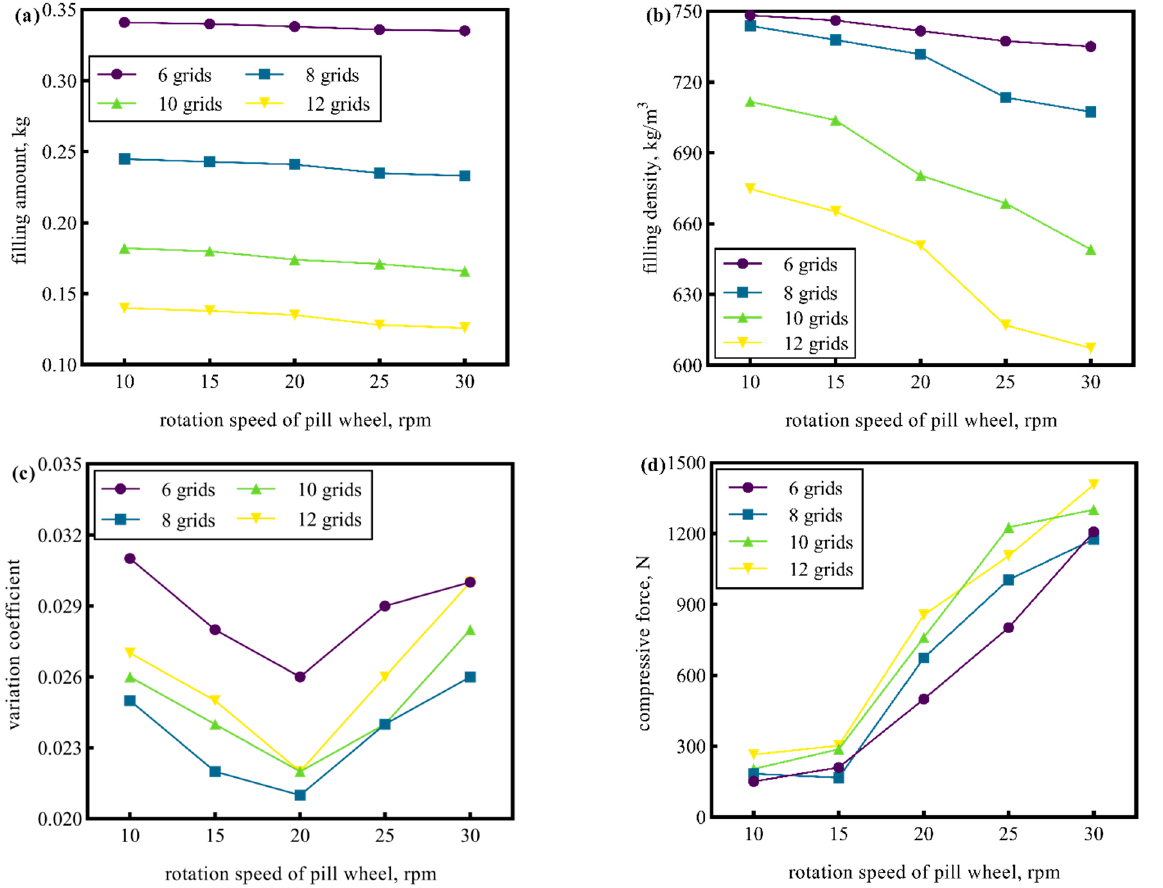
Figure 5. The effects of the grid numbers on the working performance over the rotation speed of the discharge wheel: ( a ) the filling amount; ( b ) the filling destiny; ( c ) the discharge variation coefficient; ( d ) the compressive force of the pill particles.